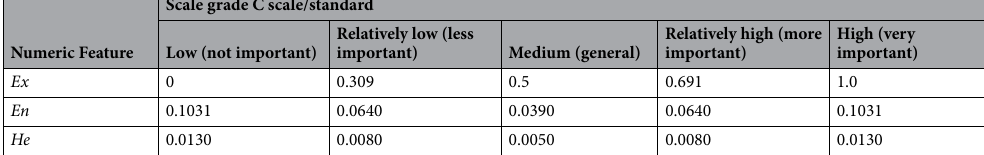
Table 1. Digital parameters of cloud of evaluation criterion and weight.